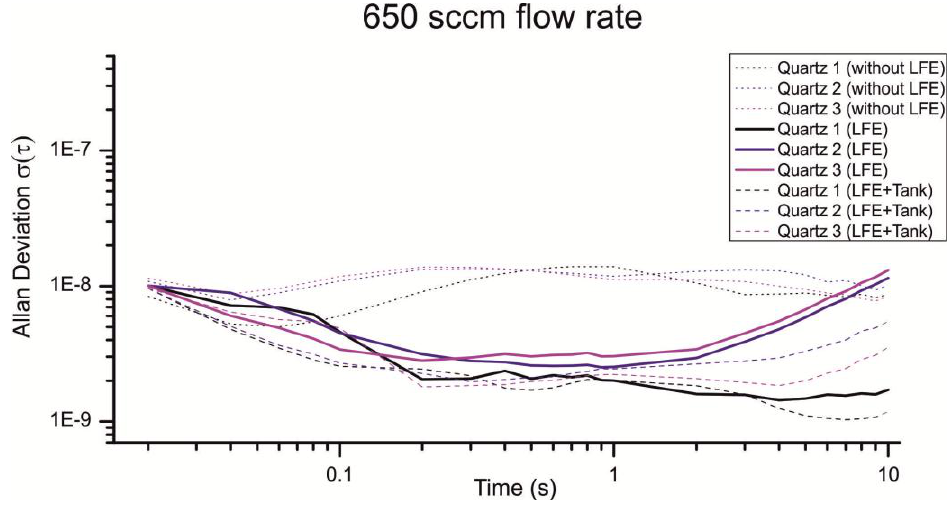
Figure 14. Comparison of different Allan deviations with a flow rate of 650 sccm. The Allan Devition was measured under the same conditions as Figure